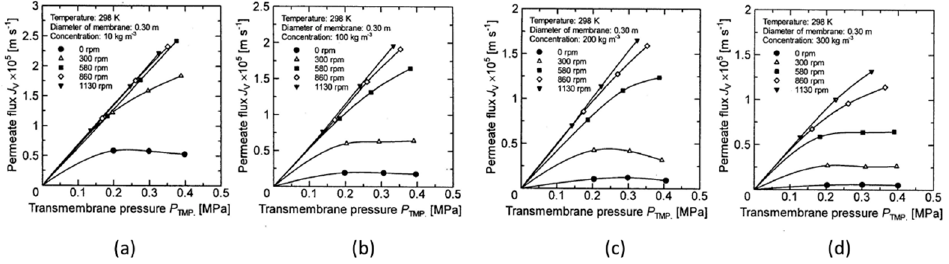
Figure 5. Relationship between measured TMP and permeate flux for disk diameter 0.3 m. ( a ) at